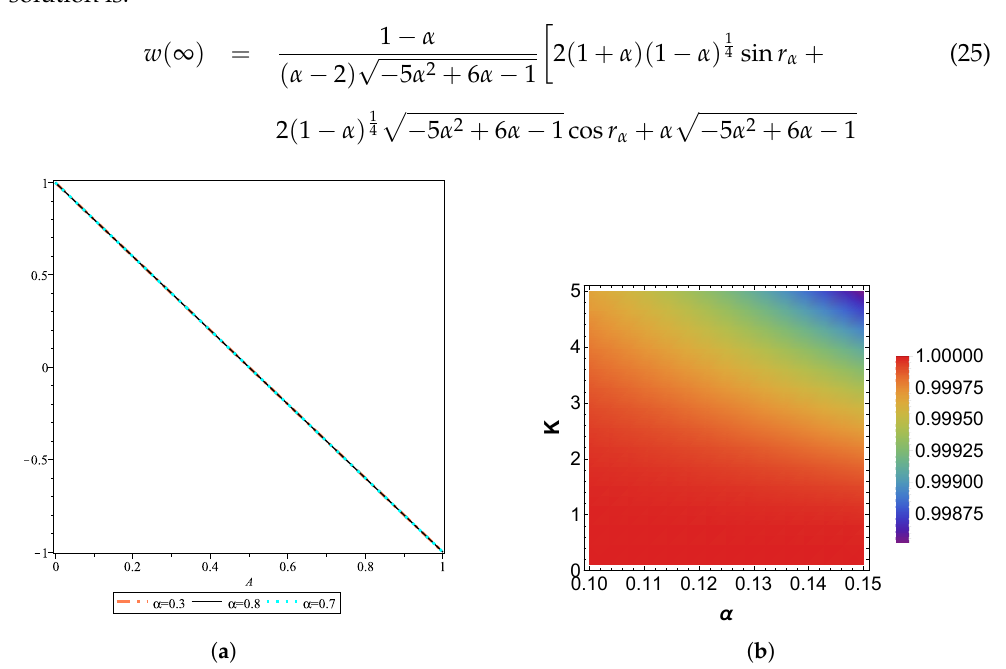
Figure 3. ( a ) Atomic population inversion left at the steady state in terms of the initial populations for A 1 = 1, K = 1 and 0 < α < 1 ; ( b ) atomic population inversion left at the steady state in terms of √ 5 K 3 for 0 < α < 1 the shape factor α and the deformation factor K, where A 1 = 5